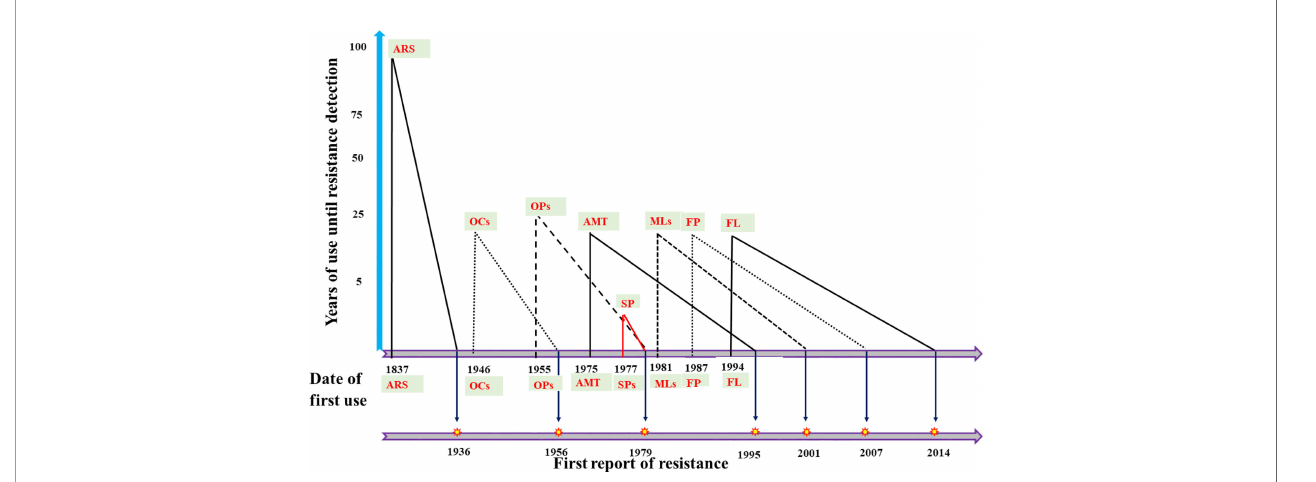
FIGURE 2 | Historical representation of acaricide introduction and fi rst reports of resistant